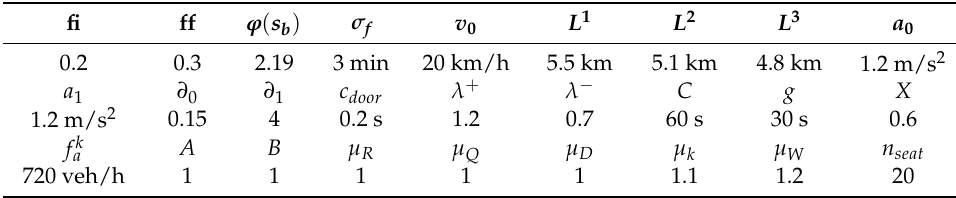
Table 1. Model parameters following appearing orders.